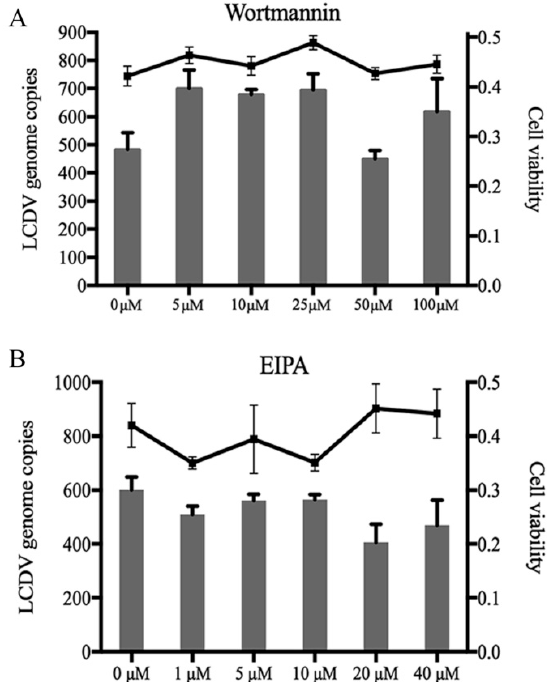
Figure 6. LCDV entry is micropinocytosis independent. FG cells were pre-incubated with wortmannin ( A ) or EIPA ( B ), LCDV copy numbers in FG cells were detected by qPCR; the histogram represents virus copy numbers and the line graph represents cell viability. FG cells treated with DMSO instead of wortmannin or EIPA served as negative controls. Error bars represent SD ( n = 3).